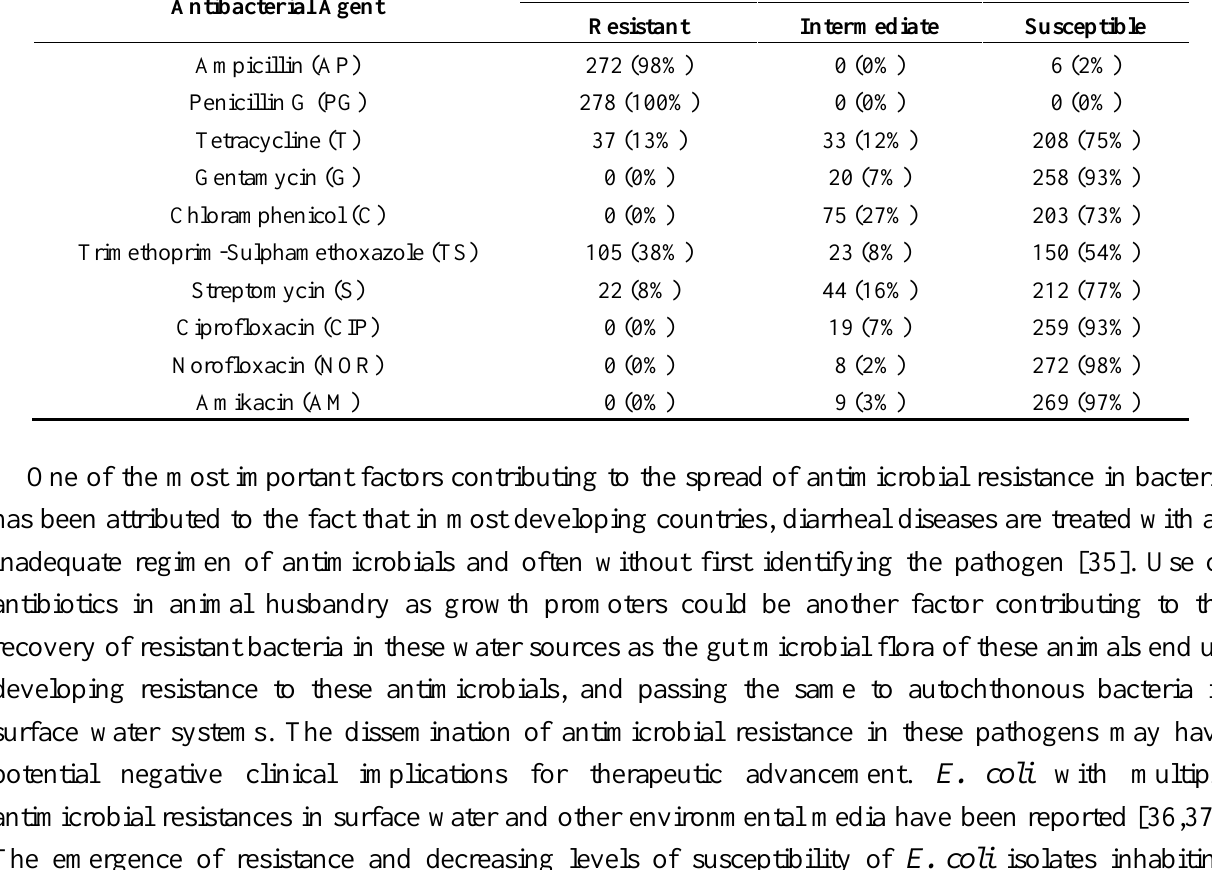
Table 4. Antibiogram of E. coli isolated from Kat River and Fort Beaufort abstraction water. Antibacterial